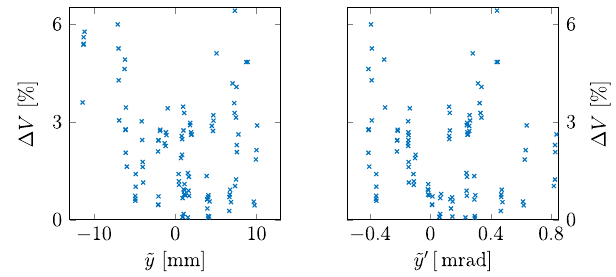
FIG. 13. Dipole mode residuals Δ V of the linear fit presented in Fig. 12 as a function of the transformed vertical trajectory offset ~ y (left) and transformed vertical trajectory angle ~ y 0 (right). No distinct systematic is identifiable in either